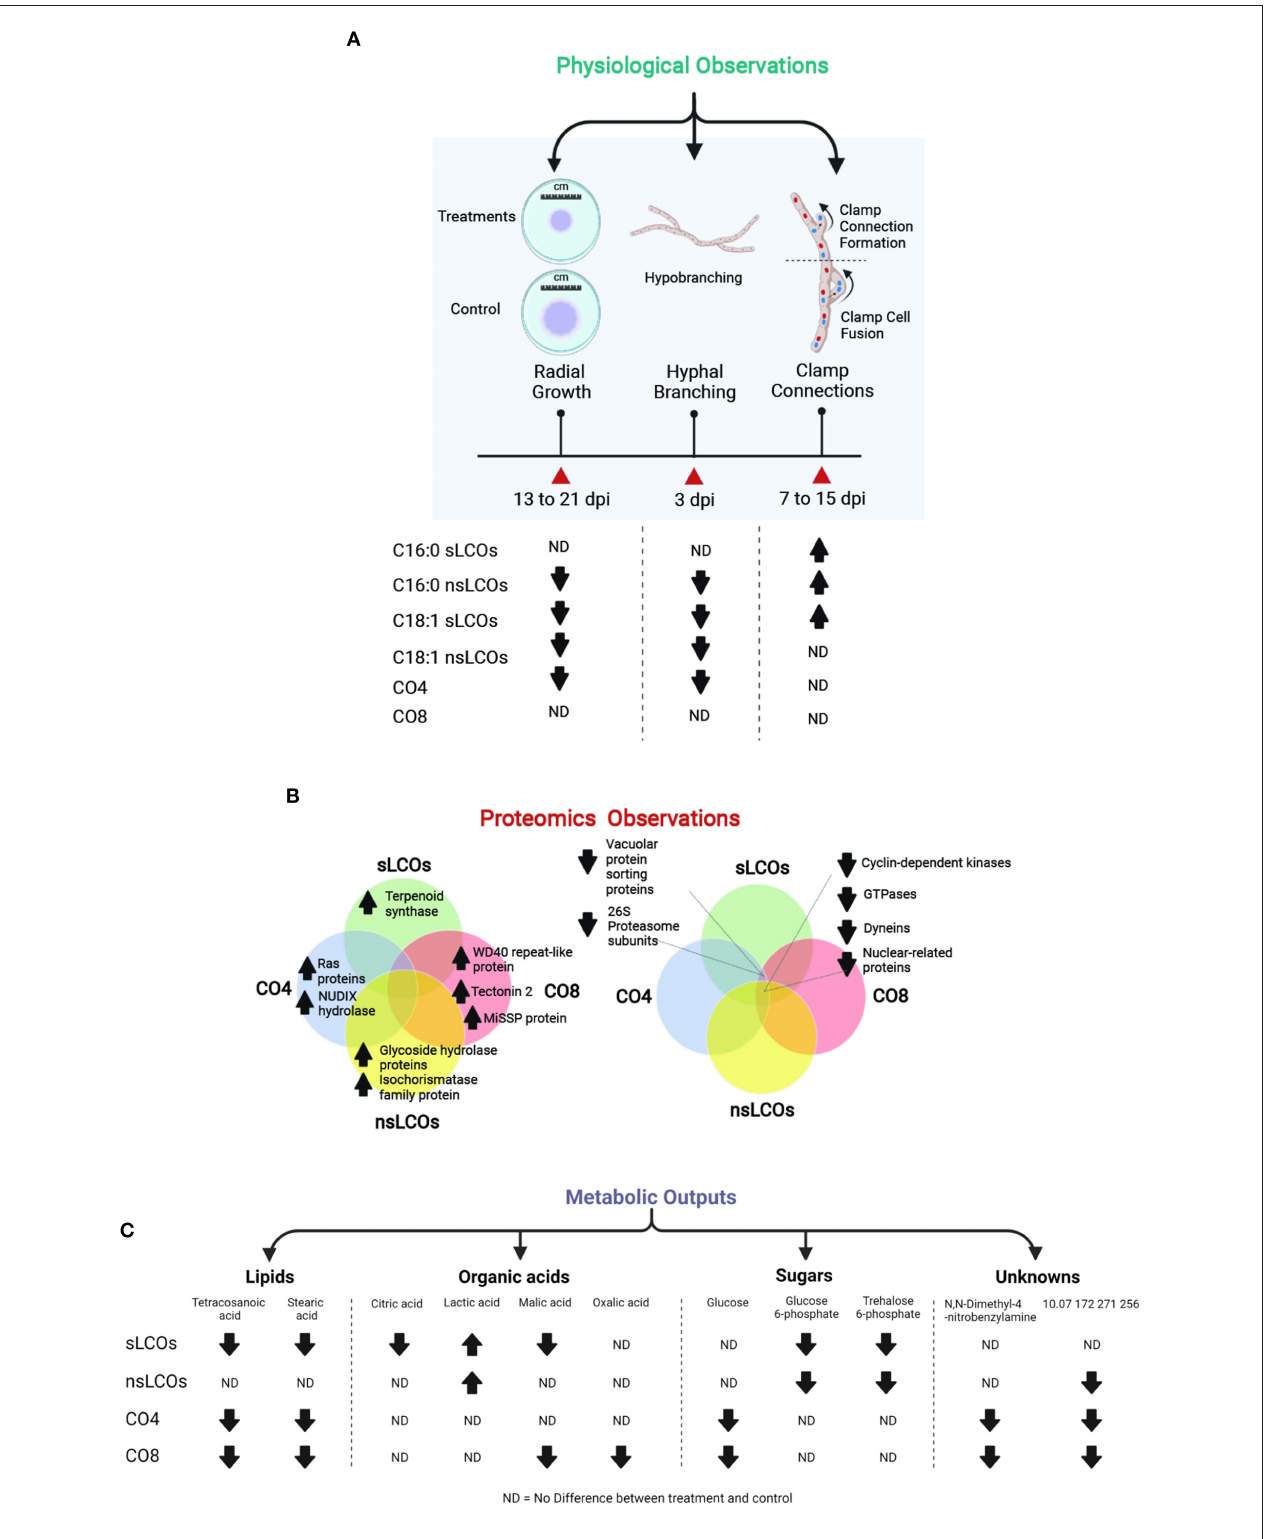
FIGURE 5 | Summary of the main physiological, proteomic, and metabolic changes observed in L. bicolor when exposed to COs and LCOs compared to control samples. (A) Reduced hyphal growth was observed in samples grown with nsLCOs, C18:1 sLCOs and CO4. (B) Most upregulated proteins quantified in this